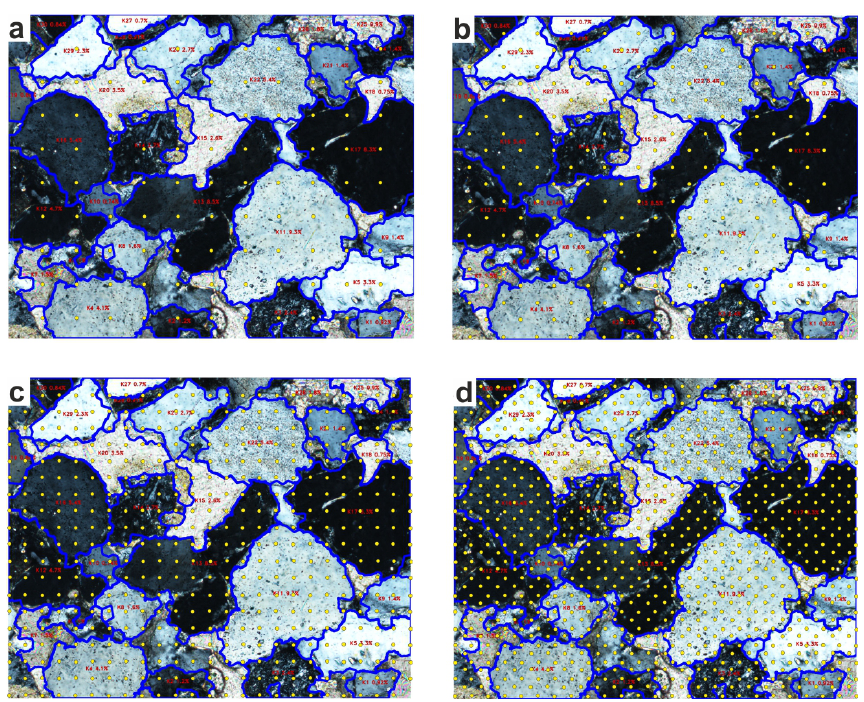
Figure 10. Four planimetric grid densities: ( a ) case I n = 100, ( b ) case II n = 210, ( c ) case III n = 474, ( d ) case IV n =